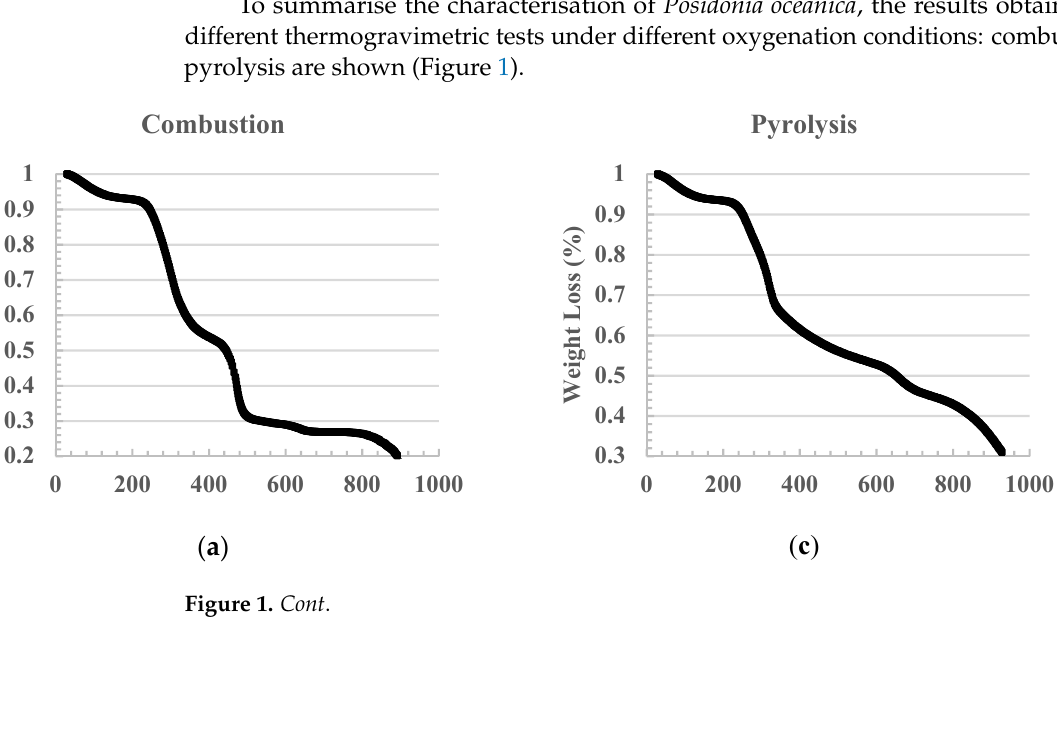
Table 1. Physicochemical characterization of the Posidonia oceanica wastes (unwashed).